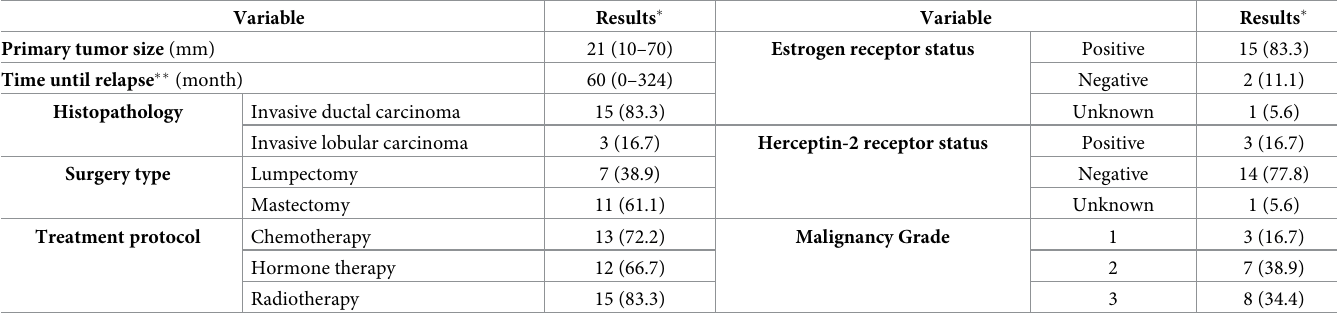
Table 1. Baseline characteristics of included patients with metastatic breast cancer.